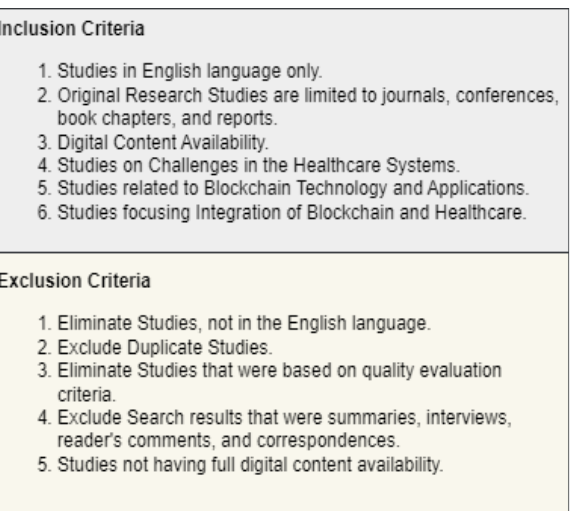
Figure 3. Criteria for screening and selection of